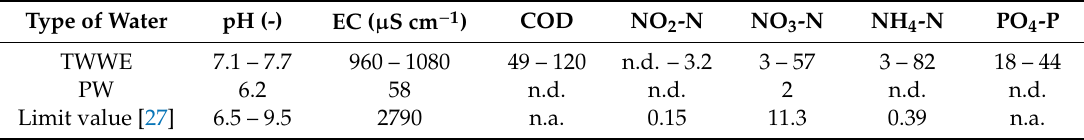
Table 2. The used TWWE (mean values) and precipitation water